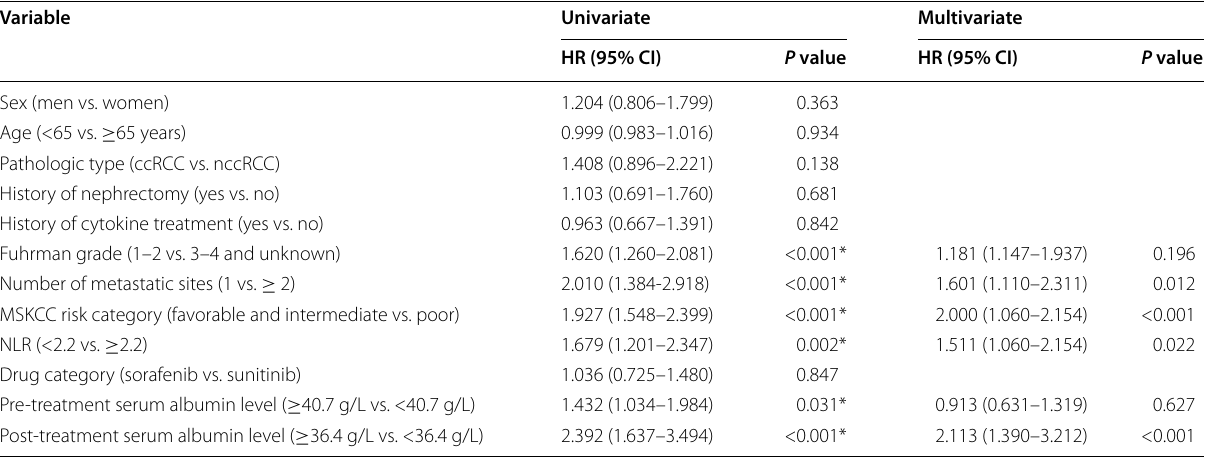
ccRCC, clear cell renal cell carcinoma; nccRCC, non-clear cell renal cell carcinoma; NLR, neutrophil-to-lymphocyte ratio; MSKCC, Memorial Sloan Kettering Cancer Center; HR, hazard ratio; CI, confidence interval * Variables with P values <0.05 in univariate analysis were considered for multivariate analysis